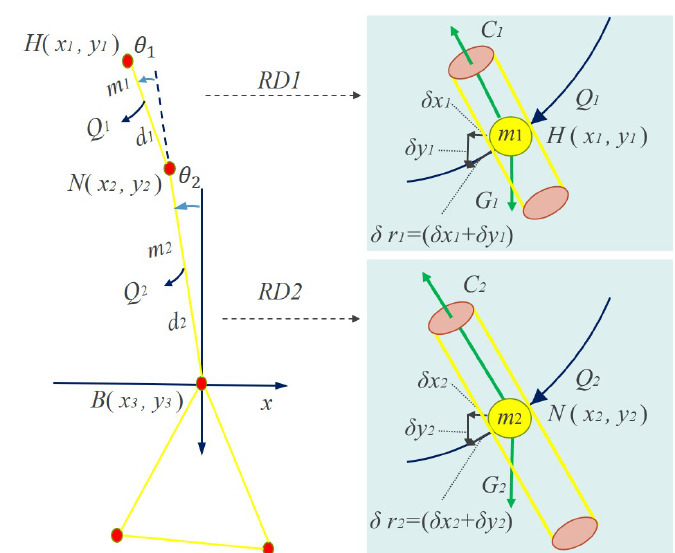
Figure 6. The two-connecting rod system based on five-point inverted pendulum mode. Here, C ( · ) is the counter-acting force and G ( · ) is the